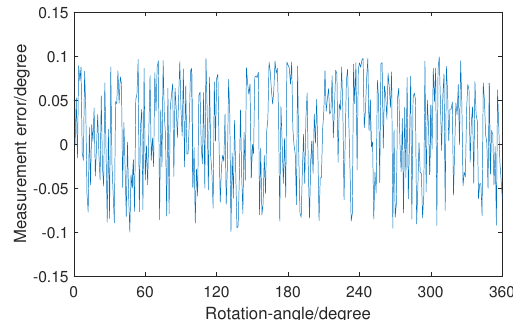
Figure 7. Measurement error of rotation angle in the experiment when the rotation angle is 1 ◦ –360 ◦ .